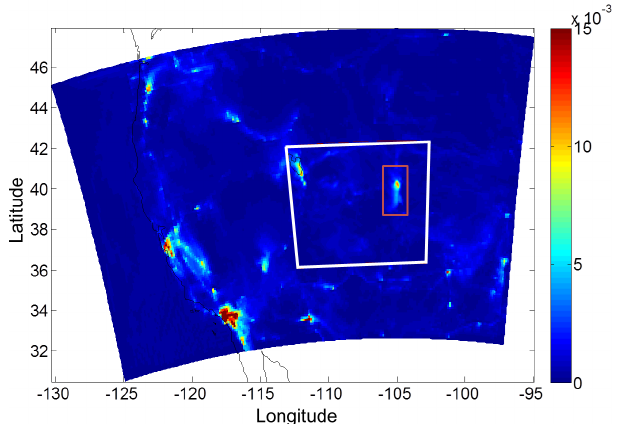
Figure 1. Model domain setup with 12km outer domain and 3km inner domain (white square). Data assimilation is performed for the inner domain. Meteorological observations in the inner domain are assimilated. TEMPO NO 2 observations inside the red rectangle are assimilated.